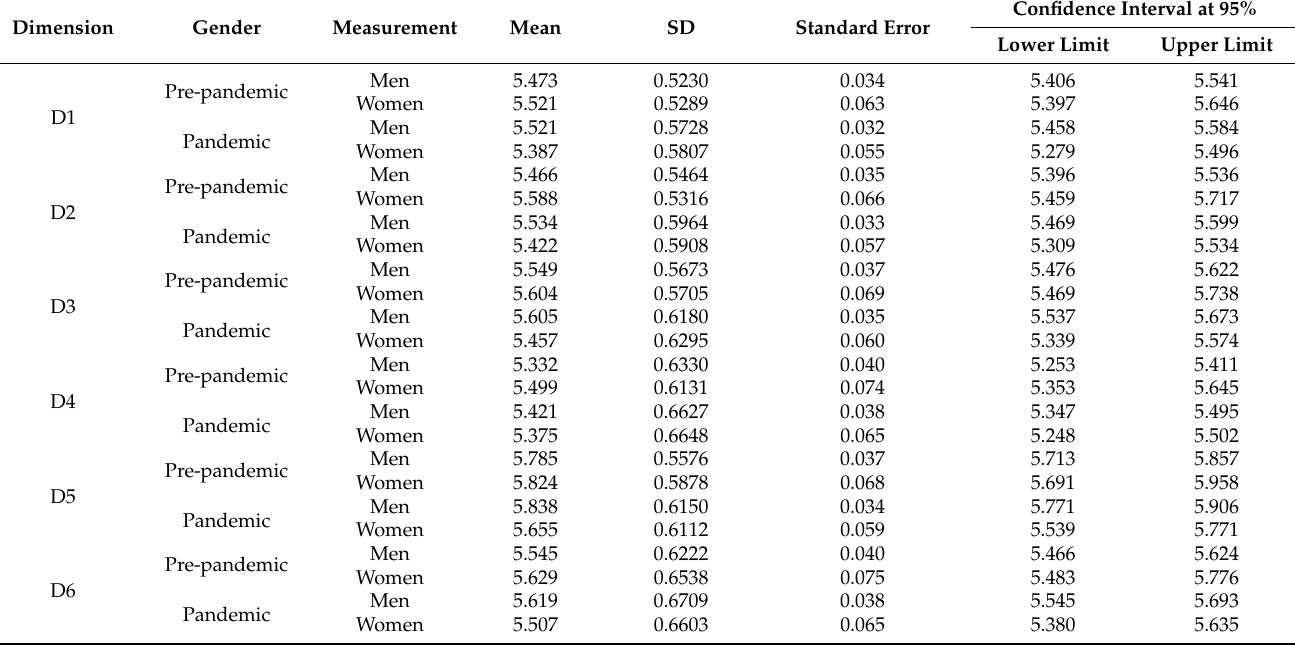
Figure 7. Before/During the pandemic + Pre-/Post-measurement. Figure 8. Before/During the pandemic + Pre-/Post-measurement. Nonetheless, the overlap of the post-measurement projections indicated that there were no differences between them before and during the pandemic. Pandemic, gender. Table 7 shows the descriptive data of the interrelation between the variables pandemic and gender. Table 7. Descriptive data of the variables pandemic vs. Table 7. Descriptive data of the variables pandemic vs. gender.